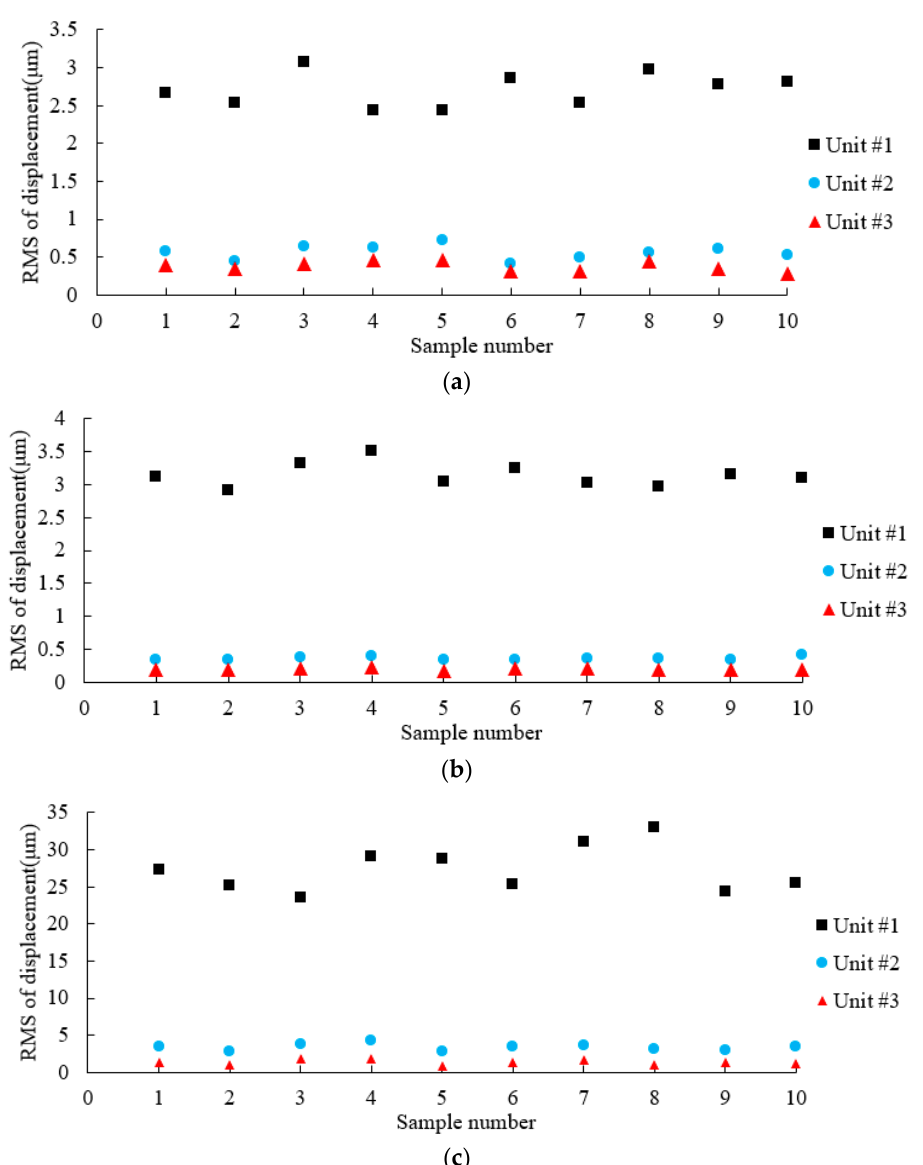
Figure 9. RMS of vibration displacements with different units in three directions: ( a ) X direction; ( b ) Y direction; ( c ) Z direction.